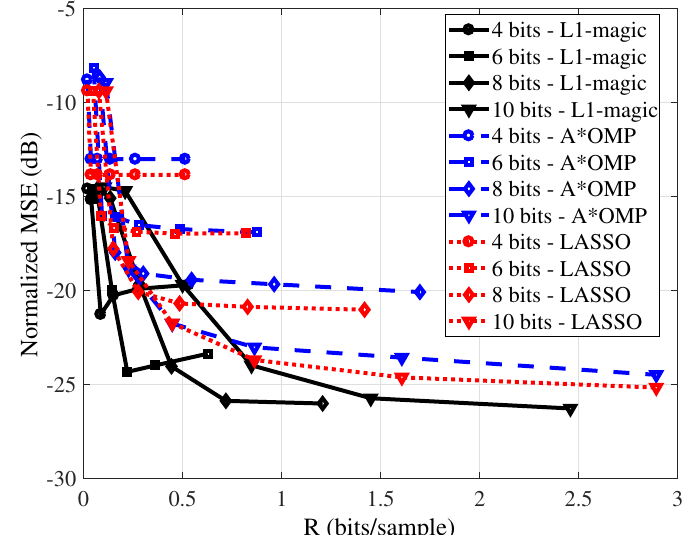
Figure 2. Rate-distortion (RD) results for a temperature signal for several quantization bit-depths using L1-magic, A*orthogonal matching pursuit (OMP), and least absolute shrinkage and selection operator (LASSO). The block length N is equal to